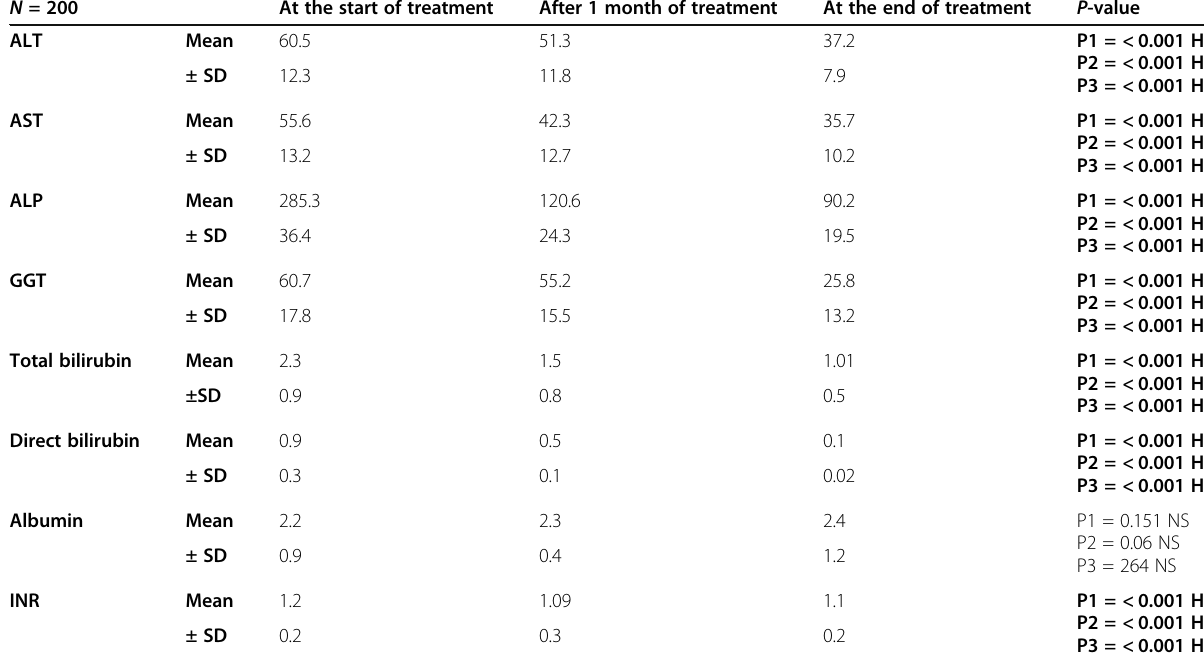
Table 3 Comparison between liver function results in the studied patients N = 200 At the start of treatment After 1 month of treatment At the end of treatment ALT